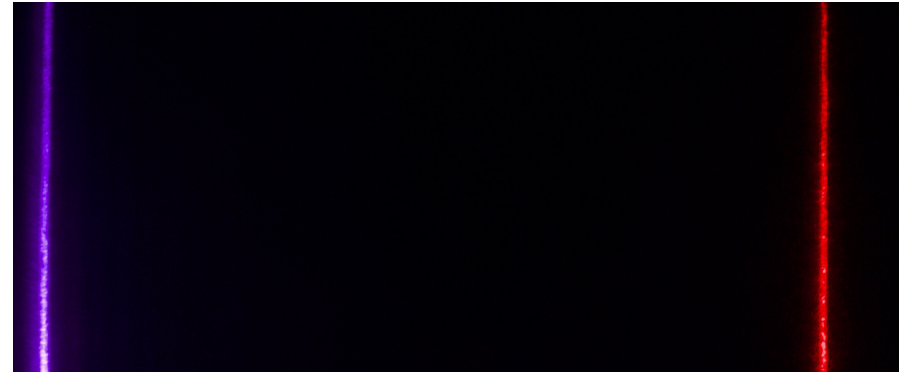
Figure 4. An example image of two laser sources imaged through the imaging setup, showing lines at 409 nm (blue/purple) and 638 nm